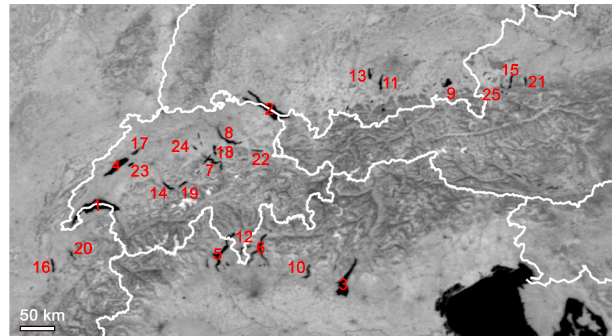
Figure 1. Clear-sky summer composite of the European Alps show- ing all lakes included in the proposed data set. Numbers 1–25 cor- respond to the list of lakes in Table